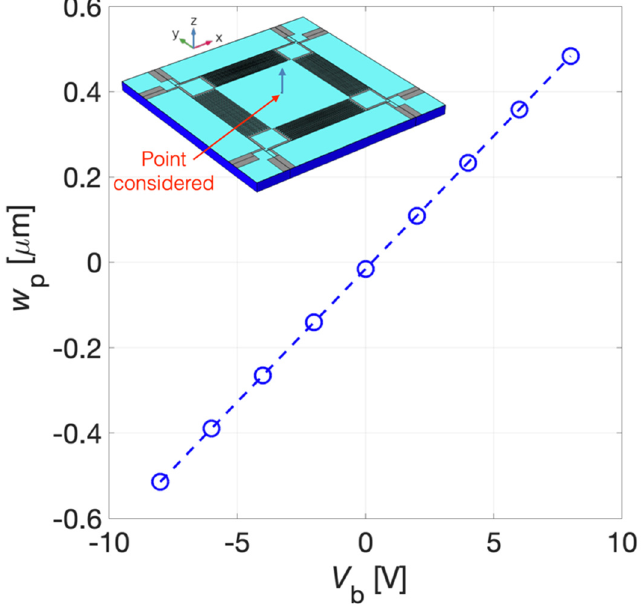
Figure 9. Z-axis displacement w p of the point reported in the inset as a function of the bias voltage V b .